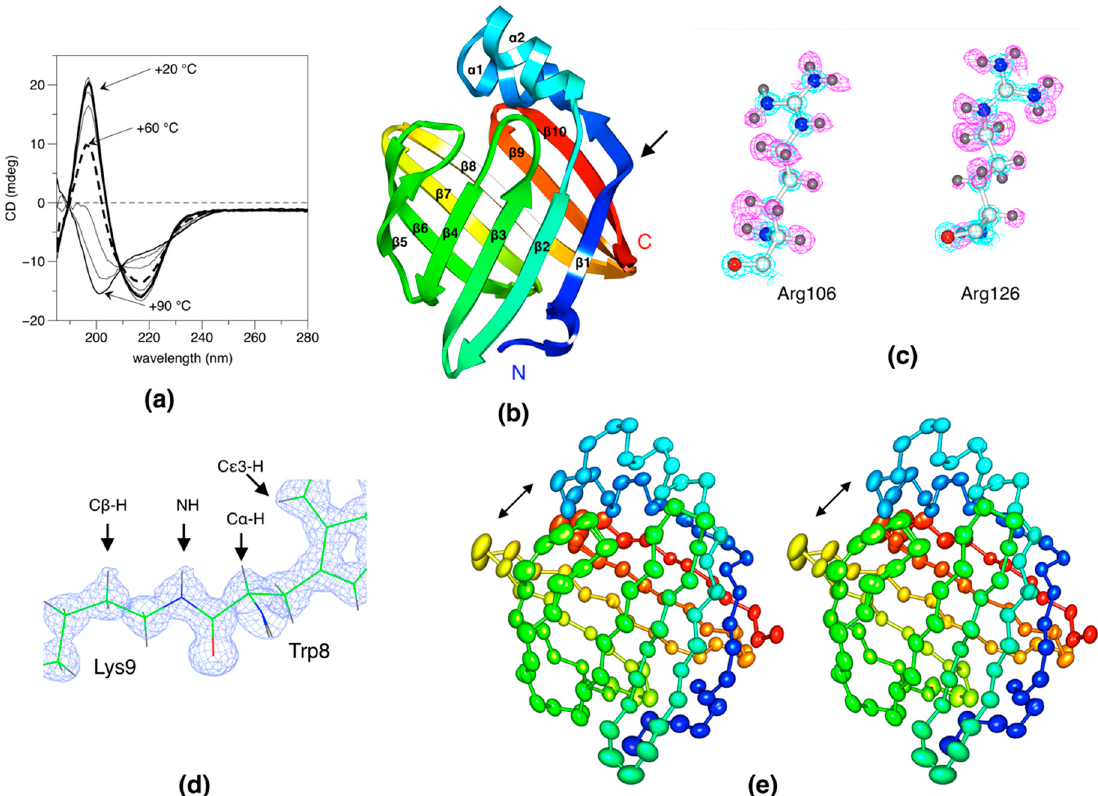
Figure 1. Structural properties of deuterated P2. ( a ) Circular dichroism (CD) spectra as a function of temperature from +20 to +90 °C. For clarity, only spectra at 10 °C intervals are shown. ( b ) Overall structure of human P2. The secondary structures and the termini are labelled. The arrow points at the bump in strand β 1. ( c ) Quality of electron density for the two Arg residues, which coordinate the bound fatty acid. The 2F o –F c map (blue) is contoured at 4.0 σ and the F o –F c map (magenta) at 2.0 σ . Note how Arg106 is deprotonated, i.e., in a neutral form, as we also reported previously [14]. The maps are for hydrogenated P2 (h-P2) at 0.86 Å resolution, calculated without hydrogen atoms. ( d ) The 2F o –F c map for perdeuterated P2 (d-P2) shows clear bumps at the positions of well-defined deuterium atoms, indicating a very high quality of the diffraction data. ( e ) Analysis of the anisotropic displacement parameters suggests open–close motions (arrows) at the portal region even in the crystal state (stereo view).